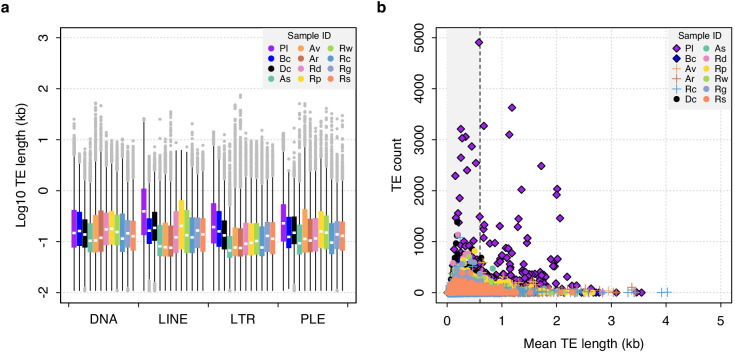
Distribution of TE lengths including the acanthocephalan P. laevis.Boxplots show the median (white band), interquartile range (box) and minimum/maximum values (whiskers; outliers shown in grey).